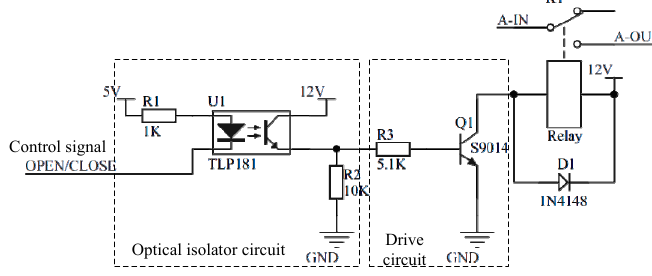
Figure 9. The schematic diagram of the breaker module.